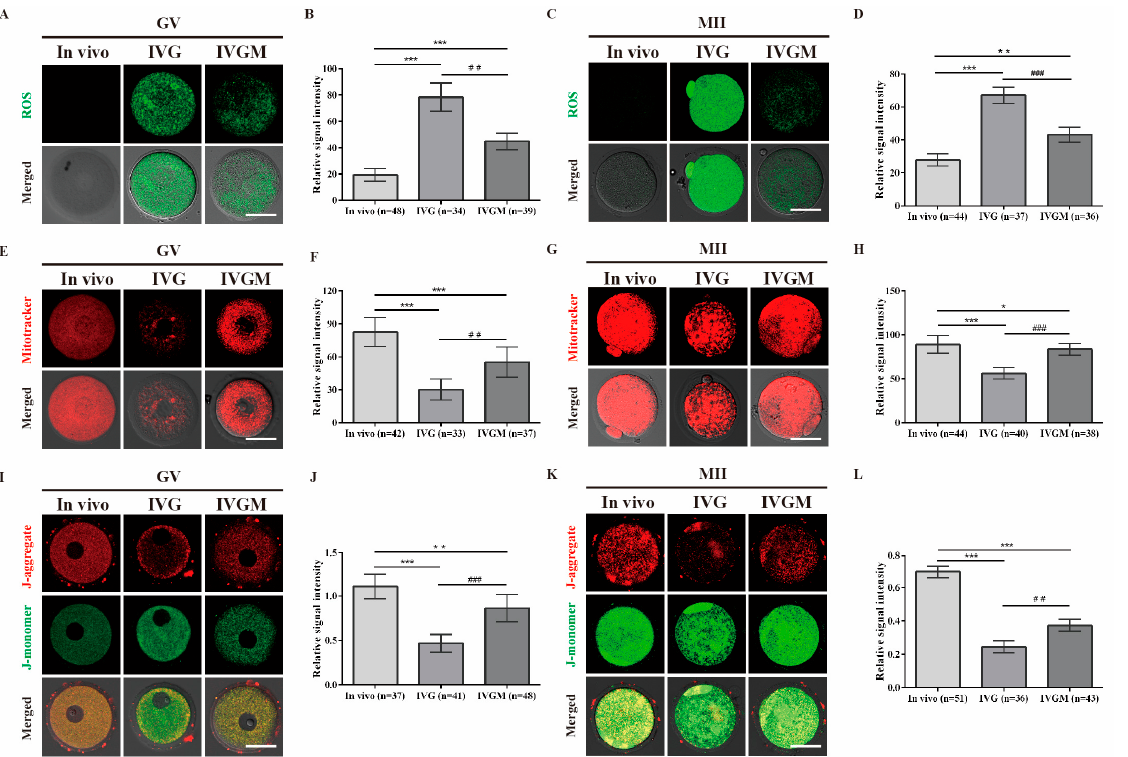
Figure 2. MitoQ improved mitochondrial function in in vitro-generated oocytes. ( A , C ) DCFH-DA staining of GV and MII oocytes, scale bar, 50 μ m. In vivo: in vivo-derived oocytes; IVG: in vitro- generated oocytes without MitoQ treatment; IVGM: in vitro-generated oocytes with 100 nM MitoQ treatment. ( B , D ) Relative fluorescence intensity of DCFH-DA staining in GV and MII oocytes. Error bars indicate SD. ** p < 0.01, *** p < 0.001, vs. in vivo group, ## p < 0.01, ### p < 0.001, vs. IVG group. ( E , G ) MitoTracker staining of GV and MII oocytes, scale bar, 50 μ m. ( F , H ) Relative fluorescence inten- sity of MitoTracker staining in GV and MII oocytes. Error bars indicate SD. * p < 0.05, *** p < 0.001, vs. in vivo group, ## p < 0.01, ### p < 0.001, vs. IVG group. ( I , K ) JC-1 staining of GV and MII oocytes, scale bar, 50 μ m. ( J , L ) The ratio of red to green fluorescence intensity in GV and MII oocytes. Error bars indicate SD. ** p < 0.01, *** p < 0.001, vs. in vivo group, ## p < 0.01, ### p < 0.001, vs. IVG group.